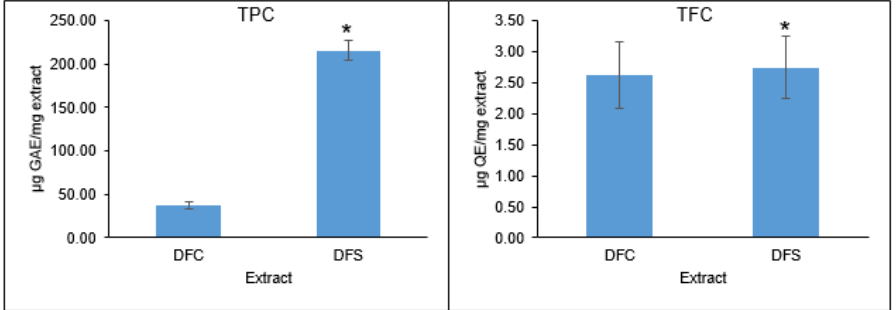
Figure 1. Effects of culture medium supplementation on TPC and TFC in DFC and DFS. Values given are means ± SD, with n = 6. * Significantly different from DFC.